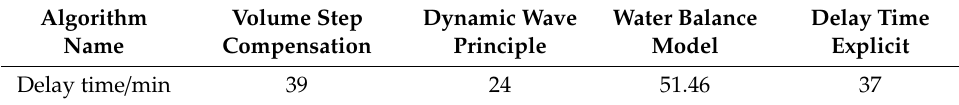
Table 2. Delay time calculated by four algorithms.